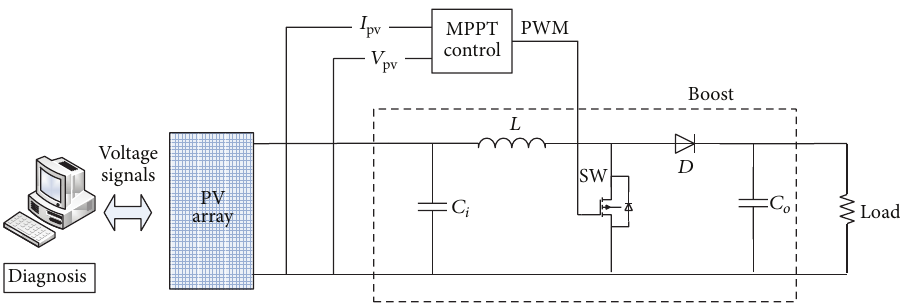
Figure 4: System architecture of the solar photovoltaic system.